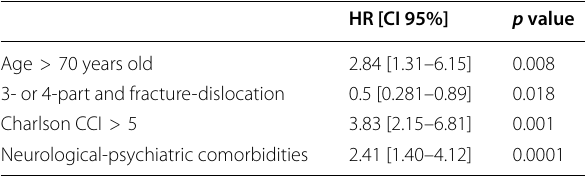
Table 2 Mortality risk factors in multivariate Cox regression survival